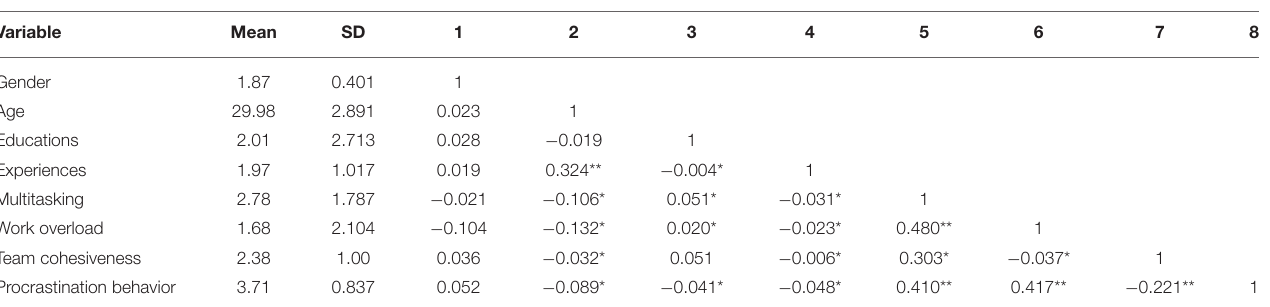
TABLE 2 | Correlation analysis of